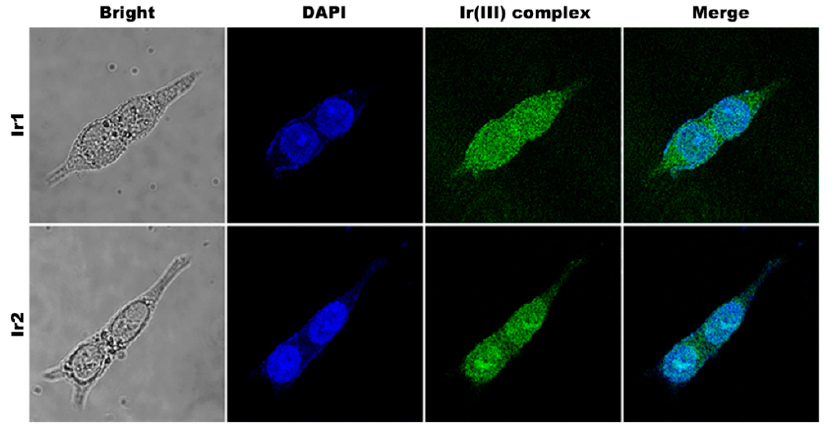
Figure 3. Cell uptake assay after HCT116 cells were exposed to IC 50 concentration of the complexes for 4 h.